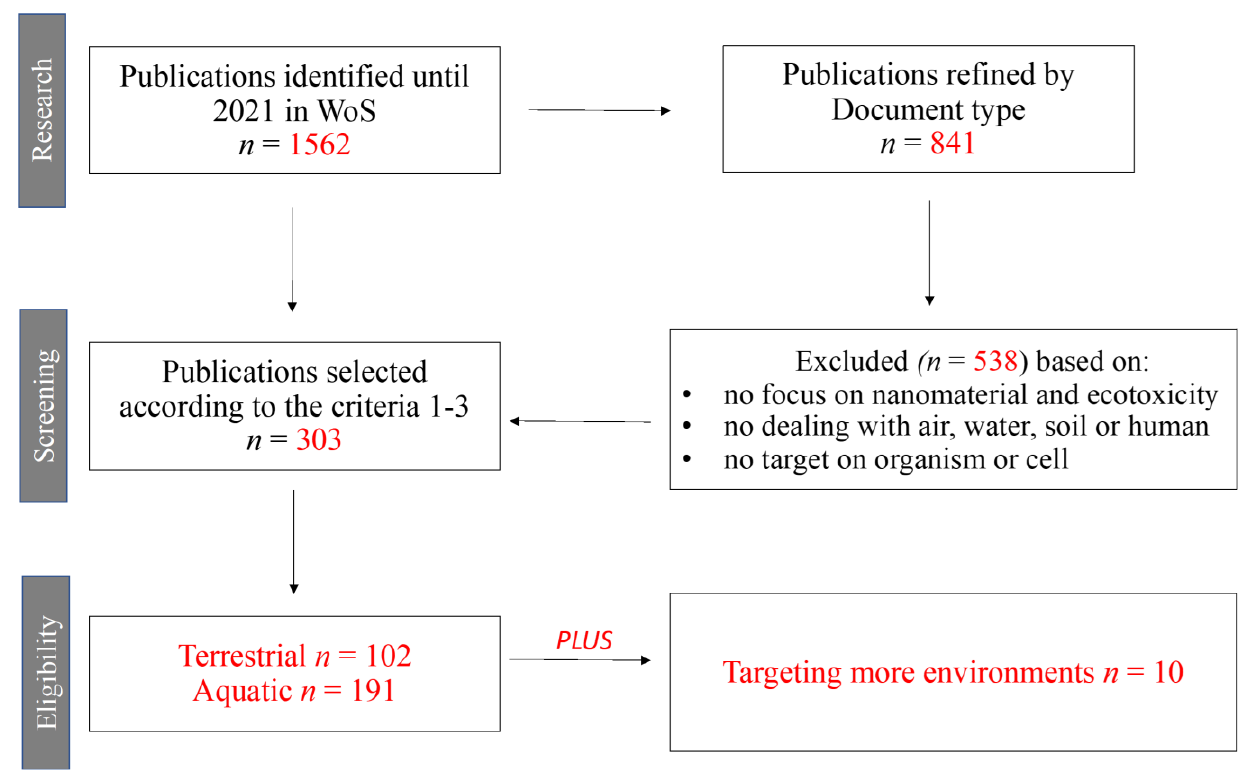
Figure 1. Flowchart of the selection process in this review.